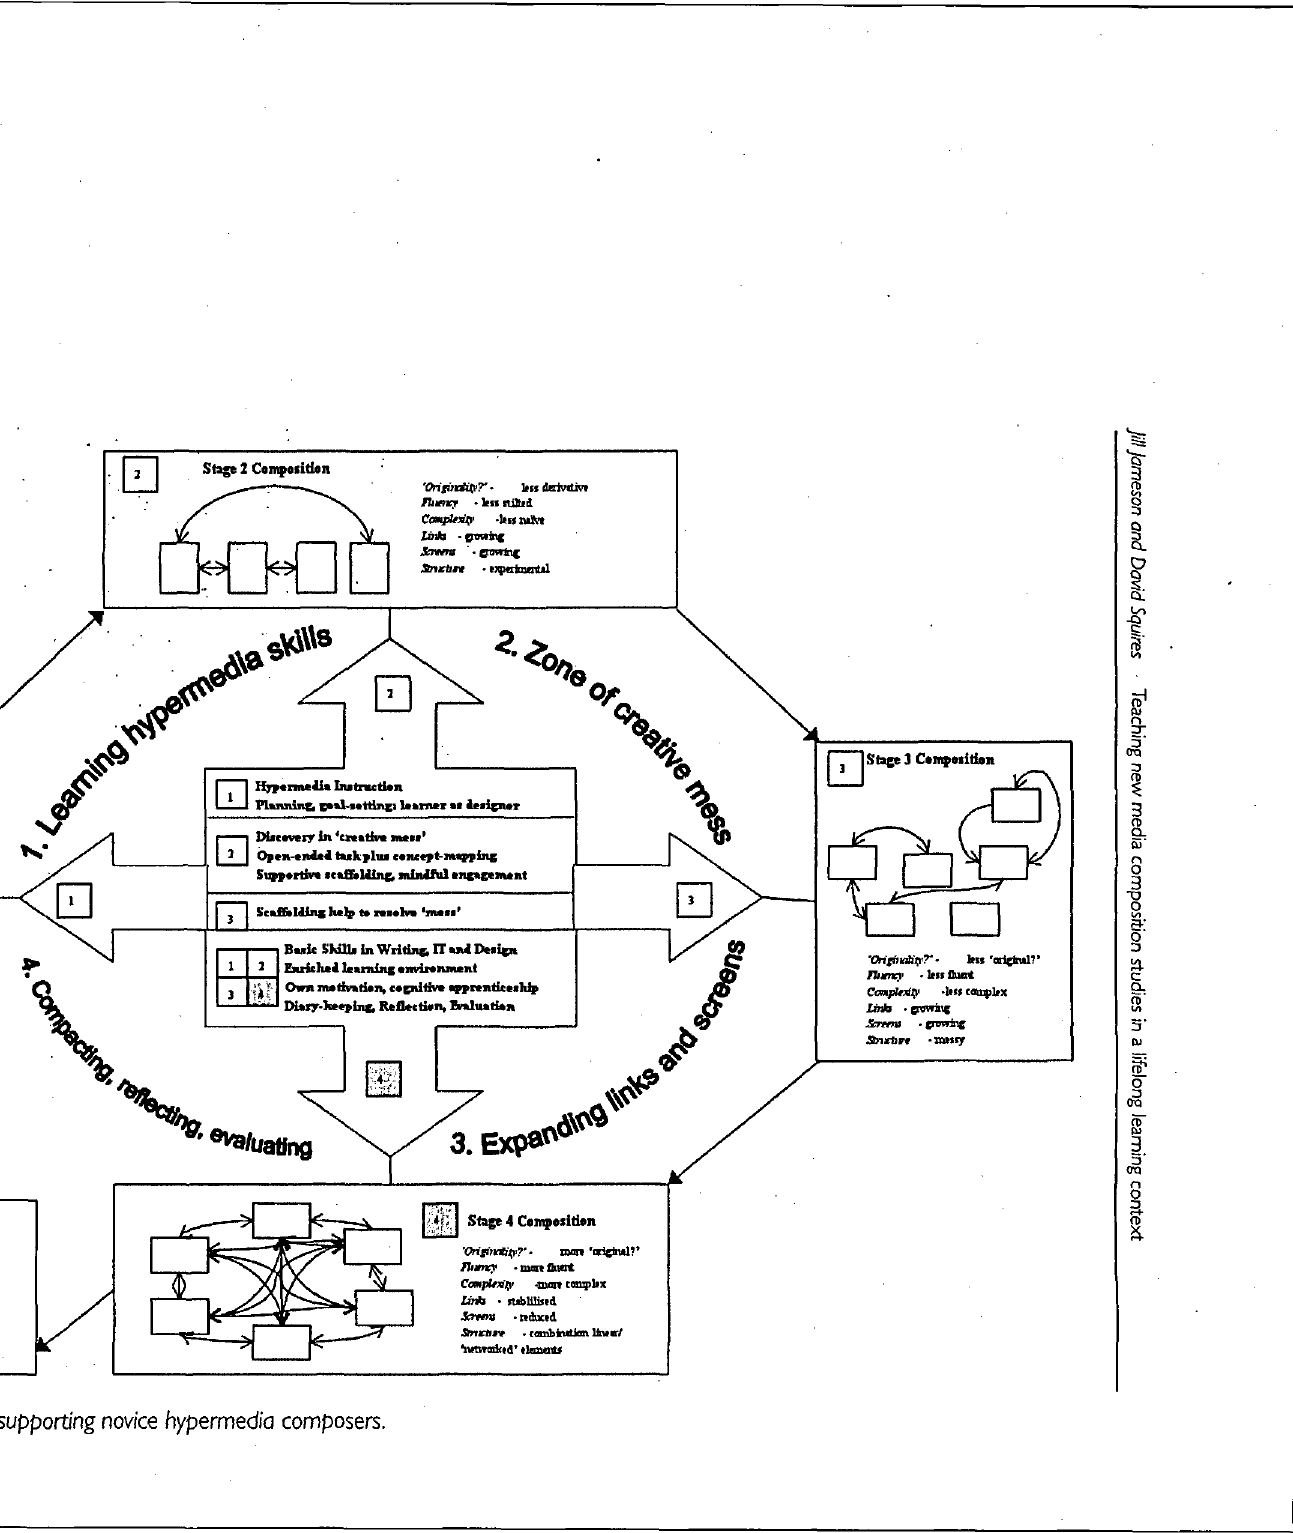
Figure 2: Teacher's mode/ for supporting novice hypermedia